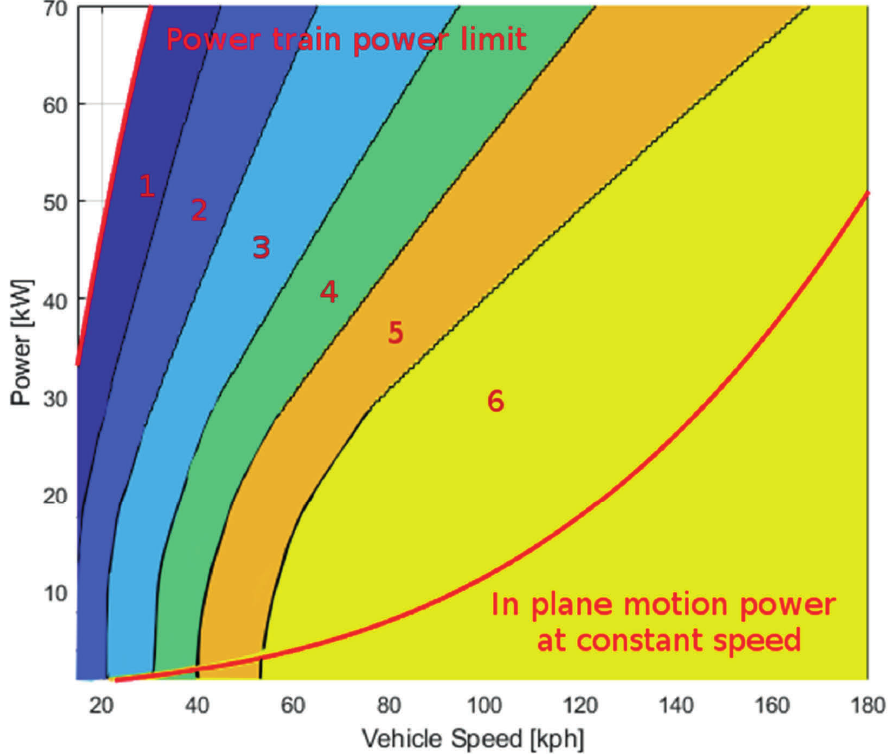
Figure 9. Optimal transmission ratio— DVT .